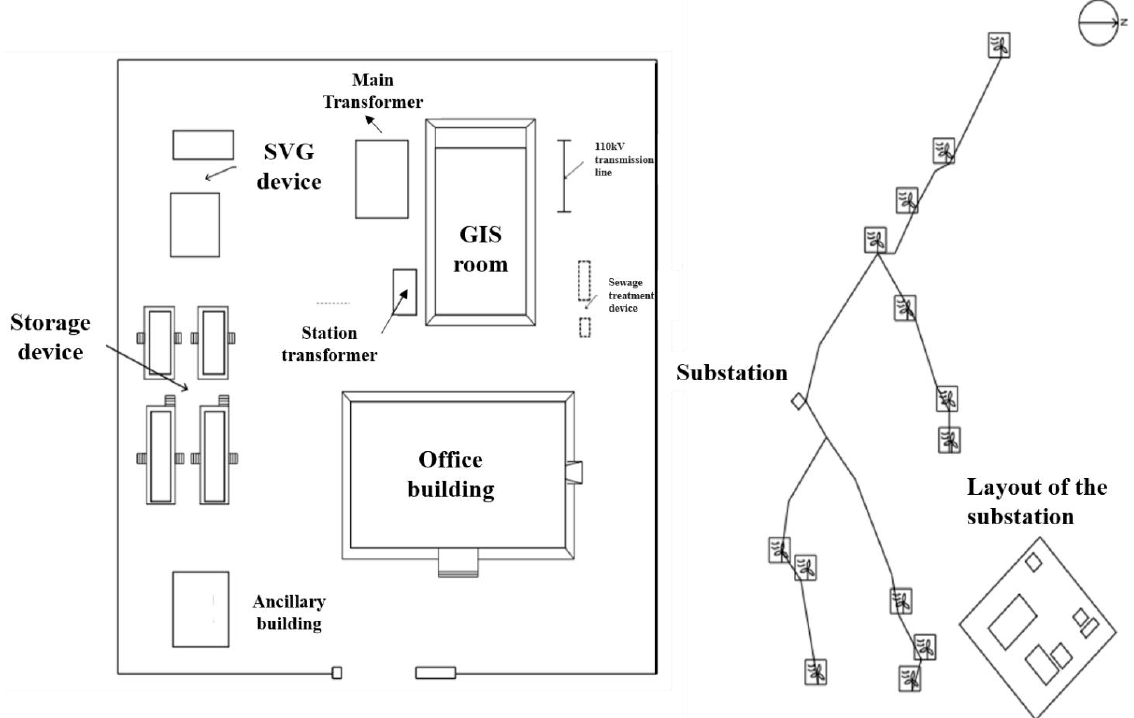
Figure 3. Structure of the wind power IES.